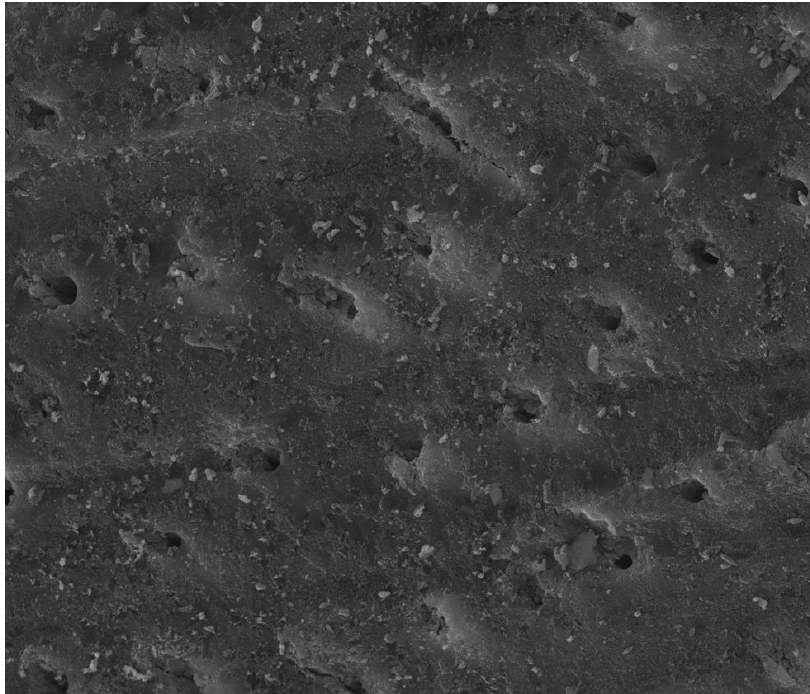
Figure 4. Scanning electron microscopy (SEM) micrograph of a dentin disc, showing notable tubule occlusion after keeping it in a mixture of artificial saliva and HA containing toothpaste for one week (6000 × magnification) (reprinted from ref. [41] with permission).